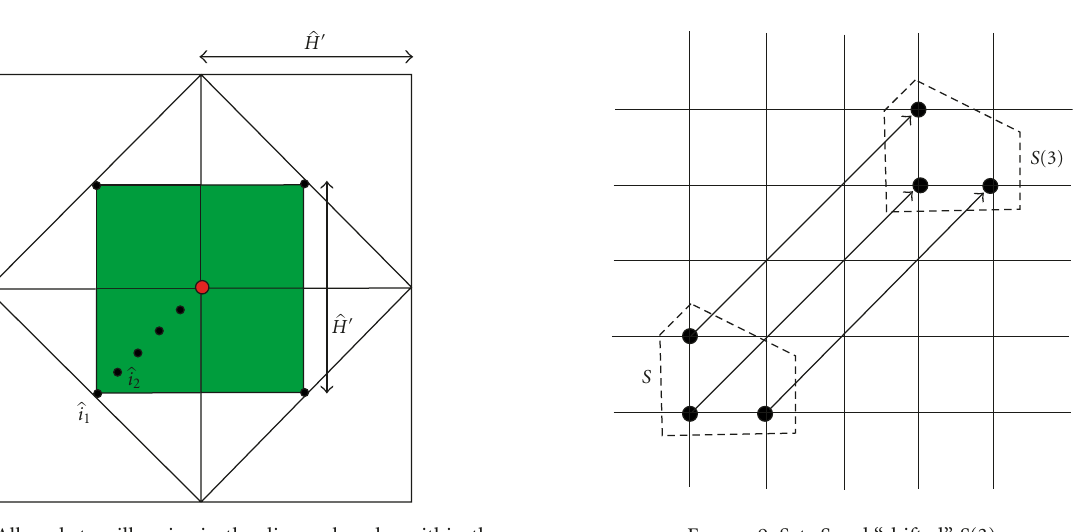
Figure 9: Sets S and “shifted” S